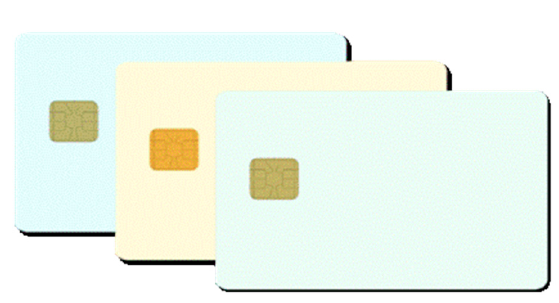
Figure 2. The form of transportation smart chips embedded in commercial credit cards.